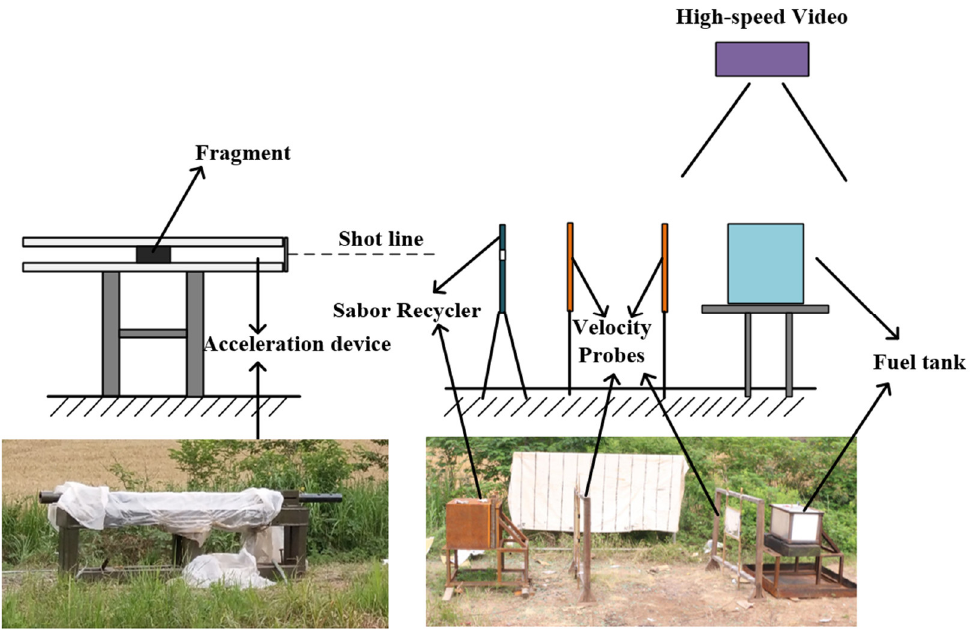
Figure 4. Schematic and photographs of experimental setup.